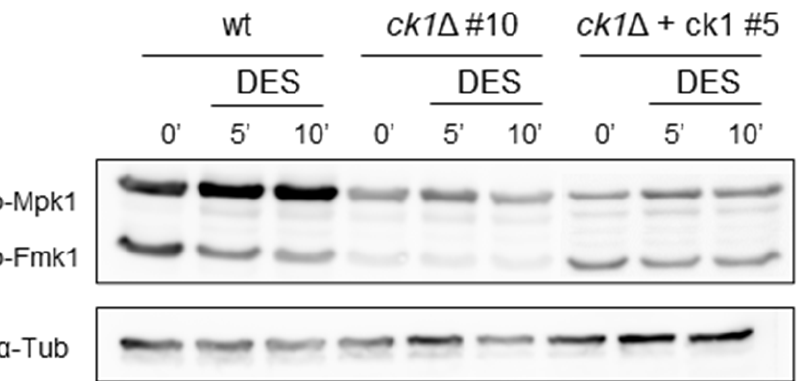
Figure 7. The ck1 ∆ mutant shows altered MAPK phosphorylation levels. Microconidia of the indicated F. oxysporum strains were germinated in PDB for 15 h at 28 ◦ C; then germlings were washed and resuspended in KSU buffer, pH 6.0. After 1 h at 28 ◦ C, 0.5 mM of the specific Pma1 inhibitor diethylstilbestrol (DES) was added. Protein extracts collected either before (time 0) or at the indicated times after DES addition, were subjected to immunoblot analysis with anti-phospho-p44/42 MAPK antibody, which specifically detects the phosphorylated version of the Mpk1 and Fmk1 MAPKs. Anti- α -tubulin ( α -Tub) antibody was used as a loading control.